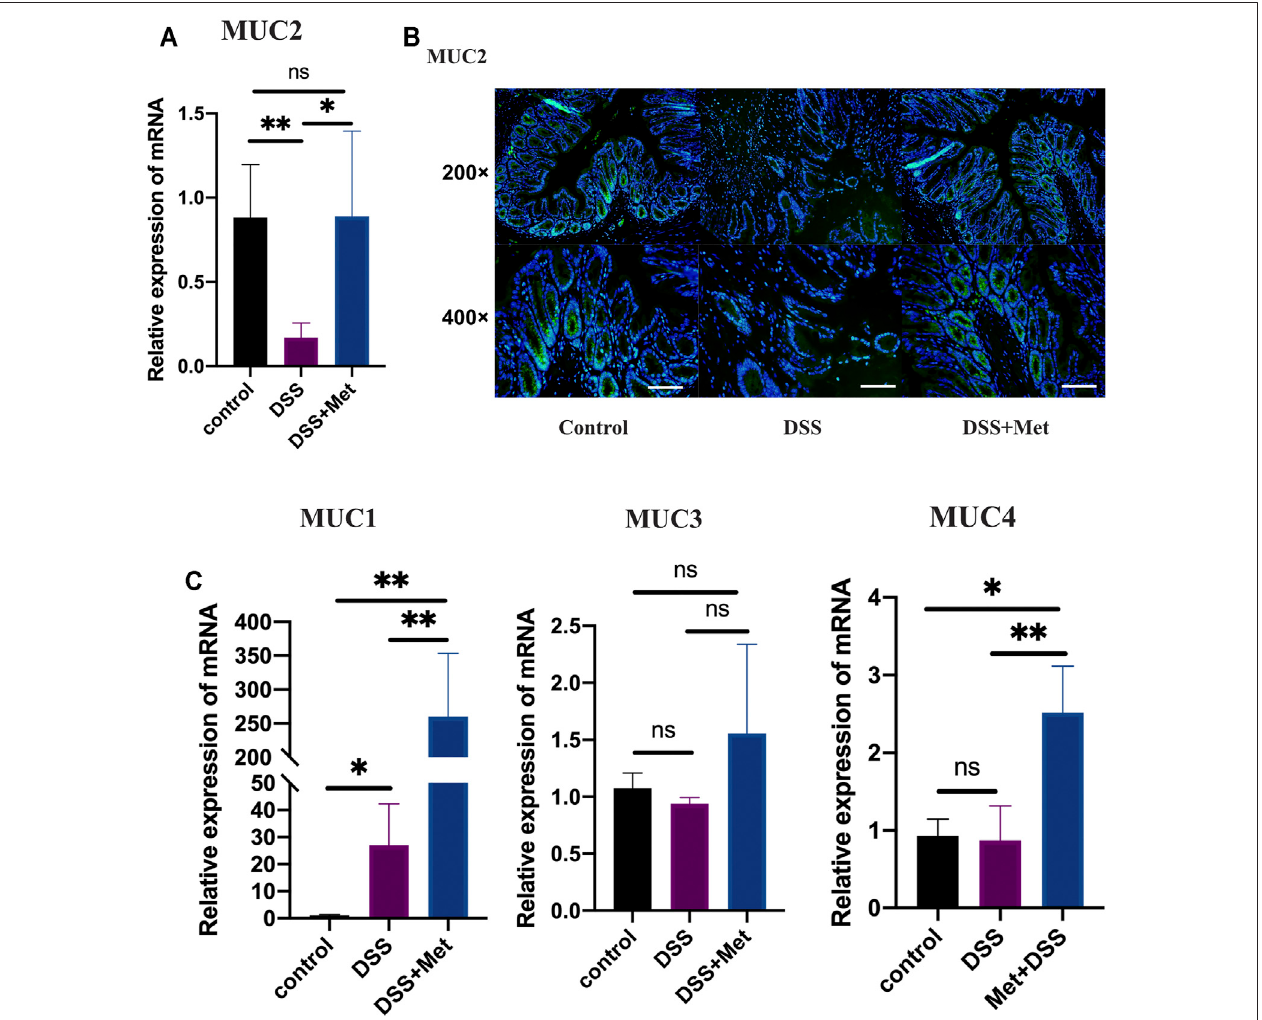
FIGURE2| Metforminprotectsthemucusbarrierbyincreasingtheexpressionofmucinsinulcerativecolitis(UC).RT-qPCRassayofmucin2(MUC2)expressionof colon tissue ( n (cid:1) 3 – 4) (A) , immuno fl uorescence assay showing the expression of mucin2 protein in colon tissue (scale bars, 200 μ m) ( n (cid:1) 4) (B) , and RT-qPCR assay ( n (cid:1) 3 – 6) of the relative expression levels of MUC1, MUC3, and MUC4 in colon tissue at mRNA level (C) and statistical comparison was made using an ANOVA test followed by Tukey-Kramer post-hoc tests. * p < 0.05, ** p < 0.01, *** p < 0.001, ns, no signi fi cance.